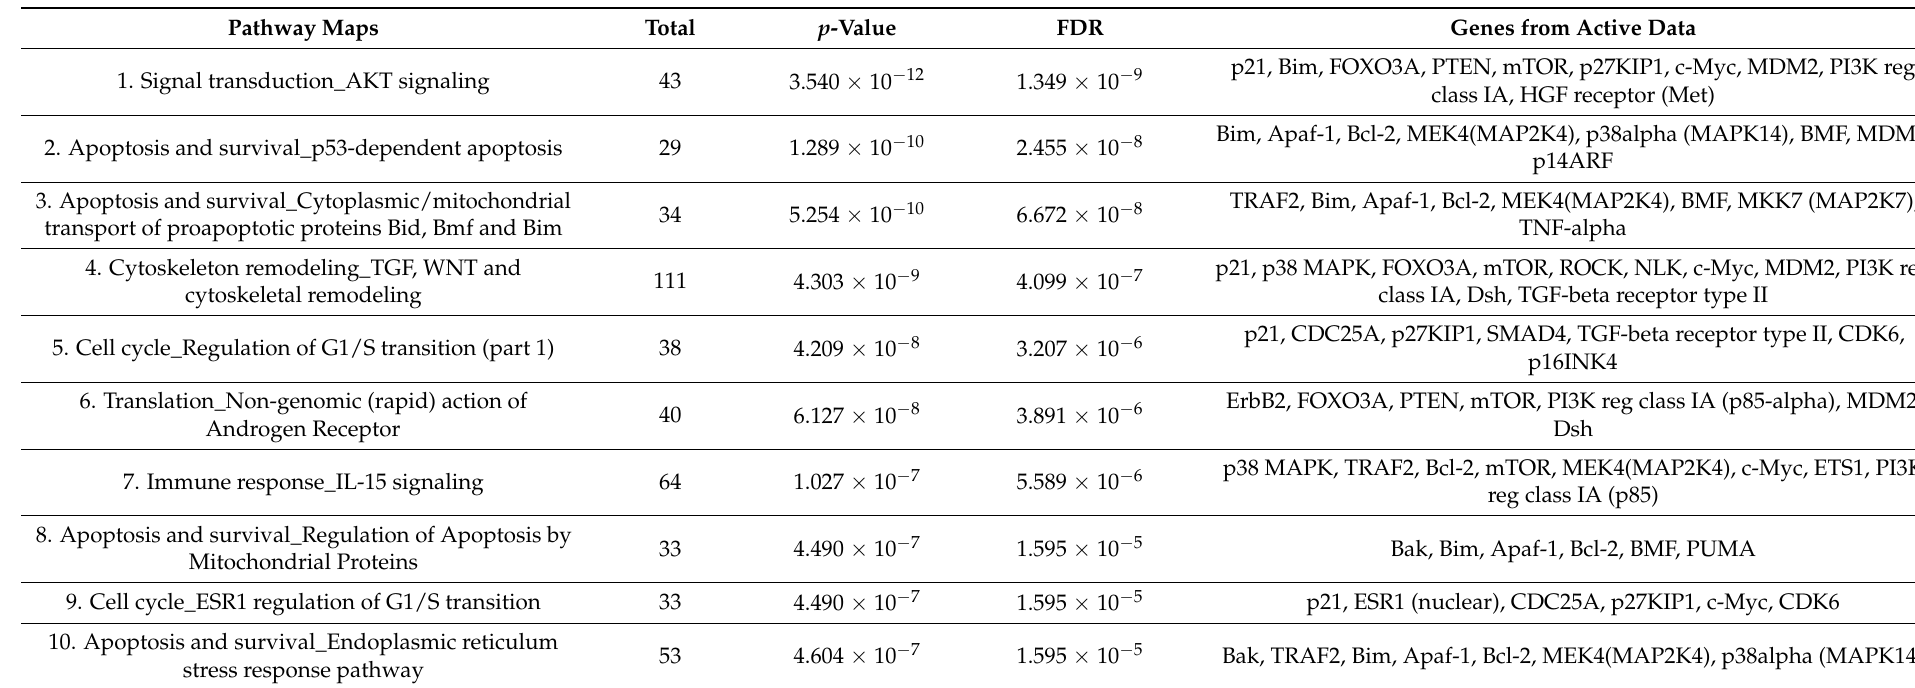
Table 2. Targets of upregulated circulating microRNAs in the plasma of patients with Kawasaki disease (KD) were involved in canonical pathway